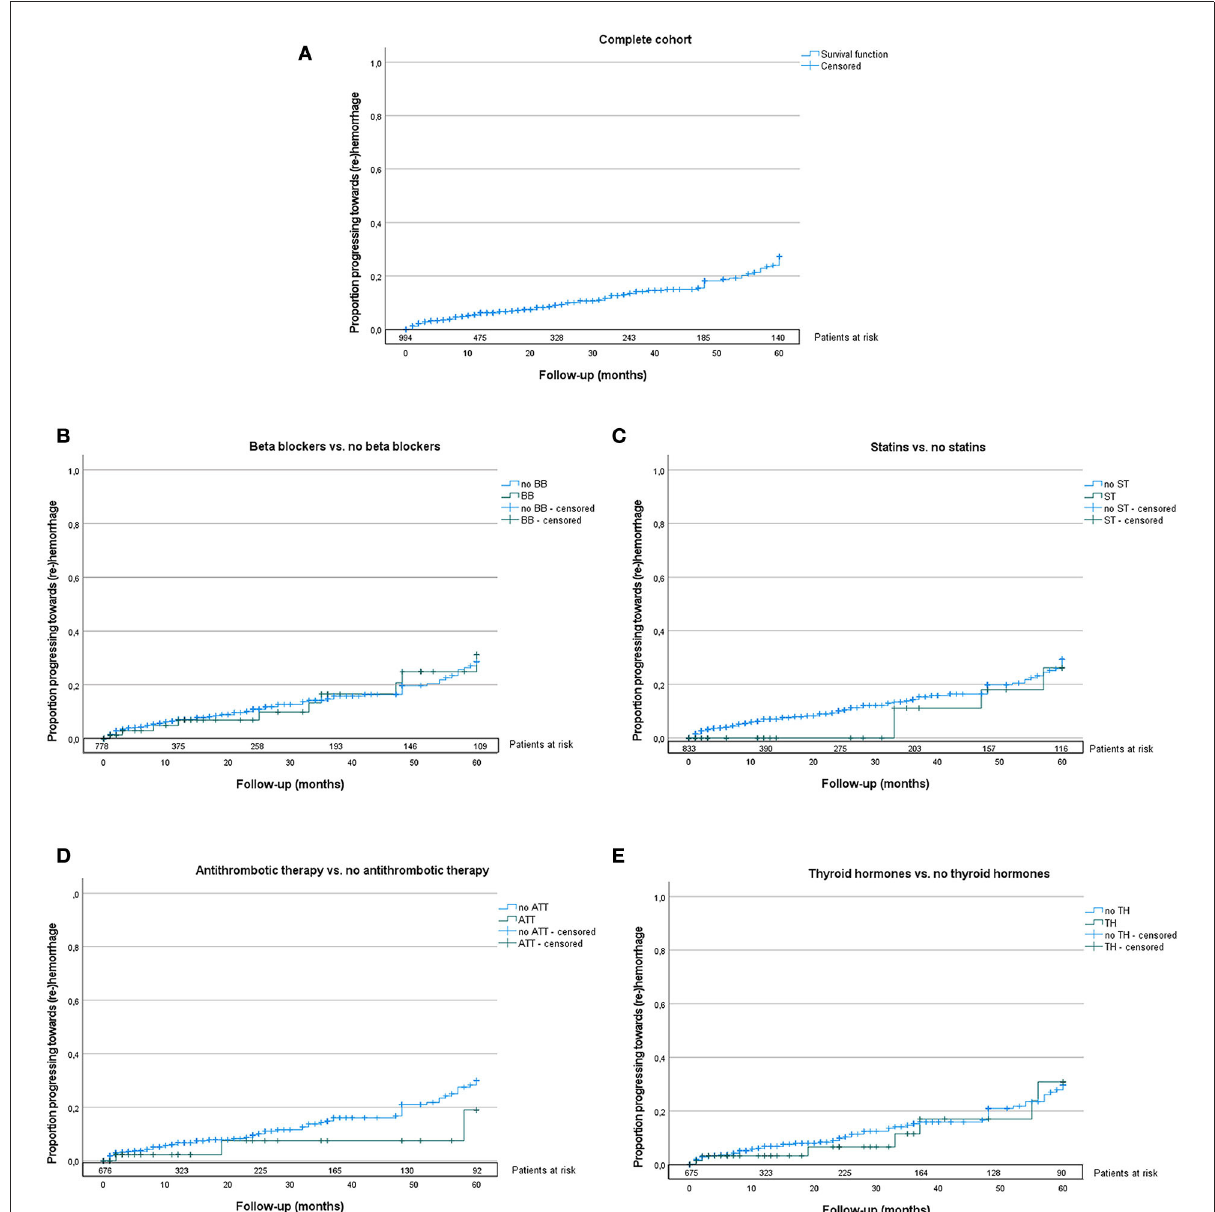
FIGURE1 Kaplan–Meier curves of the complete cohort (A) , stratified by intake of beta blockers (B) , statins (C) , antithrombotic therapy (D) , and thyroid hormones (E) are shown; drugs are depicted in green. The numbers of patients at risk are marked on top of the x -axis of each graph. The log-rank test showed no significant differences between groups in the longitudinal analysis. BB, beta blockers; ST, statins; ATT, antithrombotic therapy; TH, thyroid